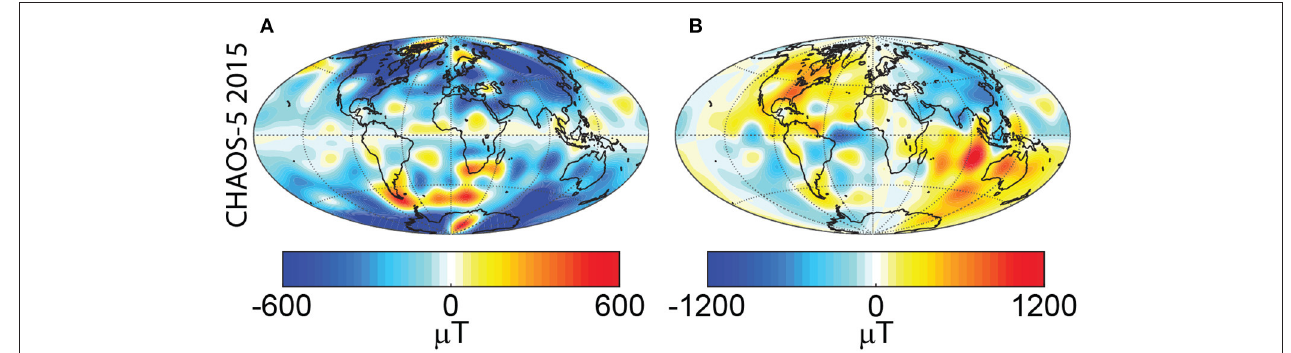
FIGURE 4 | Geomagnetic dipole integrands for the axial m z (A) and equatorial m e (B) components for the year 2015 of CHAOS-5 (Finlay et al., 2015).